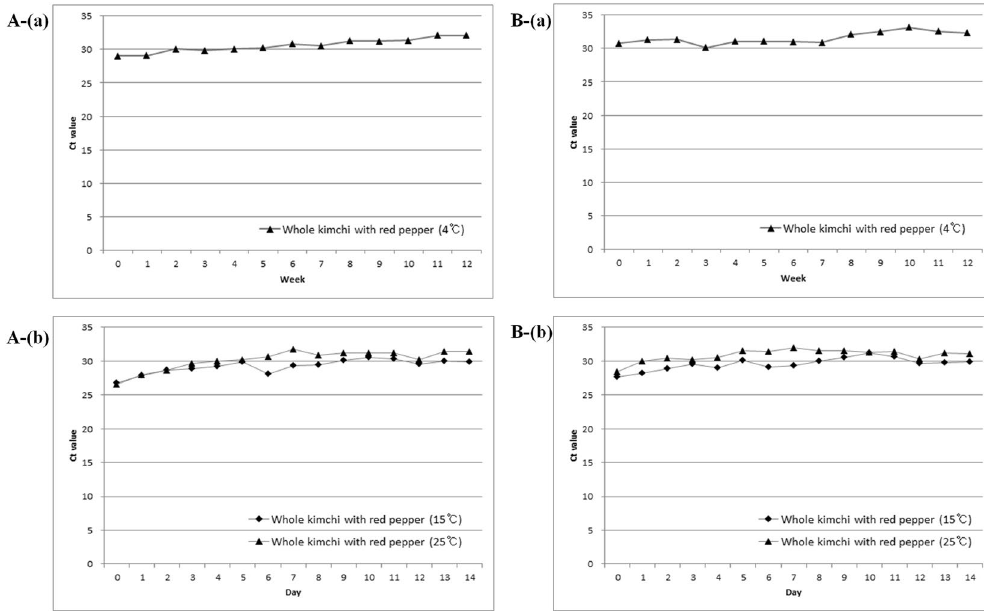
Figure 3. Changes in the real-time PCR Ct values during the quantification of Bacillus velezensis ( A ) and B. subtilis subsp. subtilis ( B ) using total DNA isolated from salted Chinese cabbage kimchi fermented at 4 °C (a), 15 °C and 25 °C